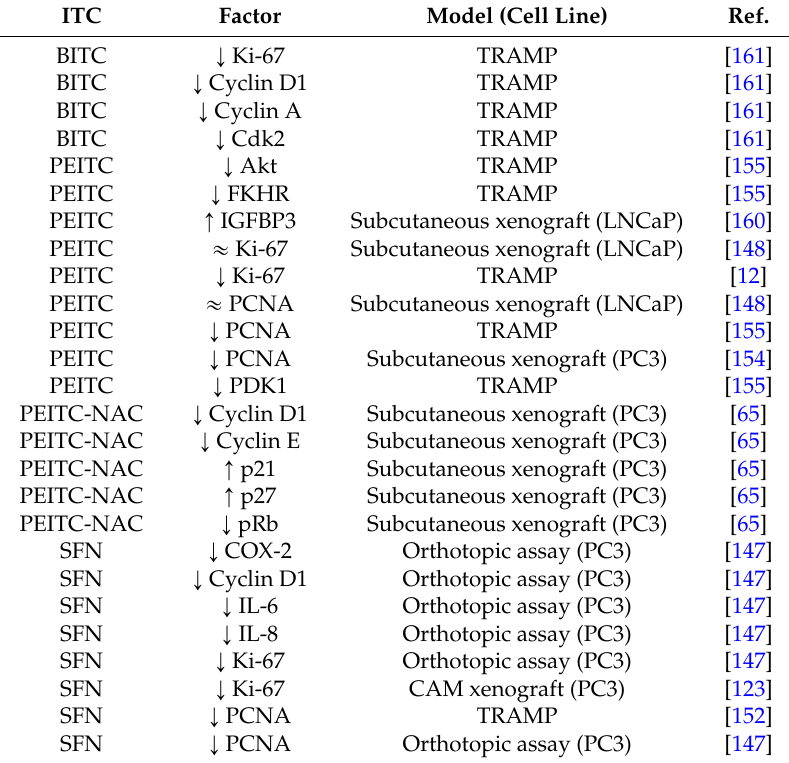
Table 5. ITCs inhibit the in vivo and ex vivo growth of prostate tumors by inhibiting tumor cell